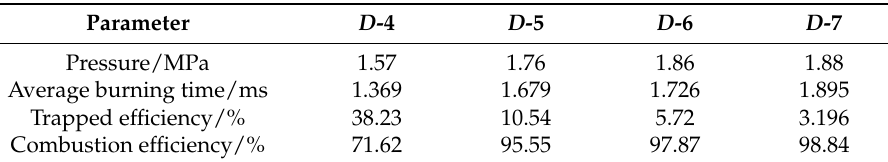
Table 2. Calculation result parameter distribution.